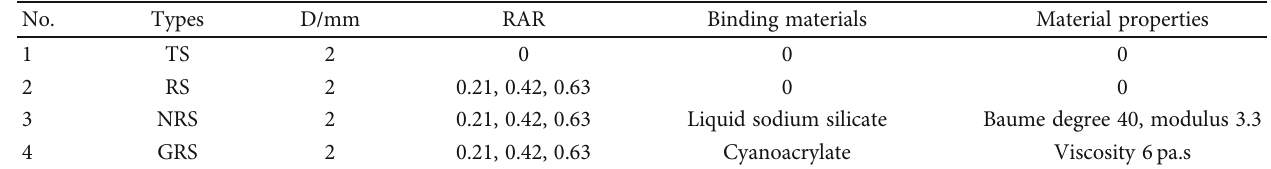
Figure 3: Root pulling test of A. fruticose. Table 3: Sample number and